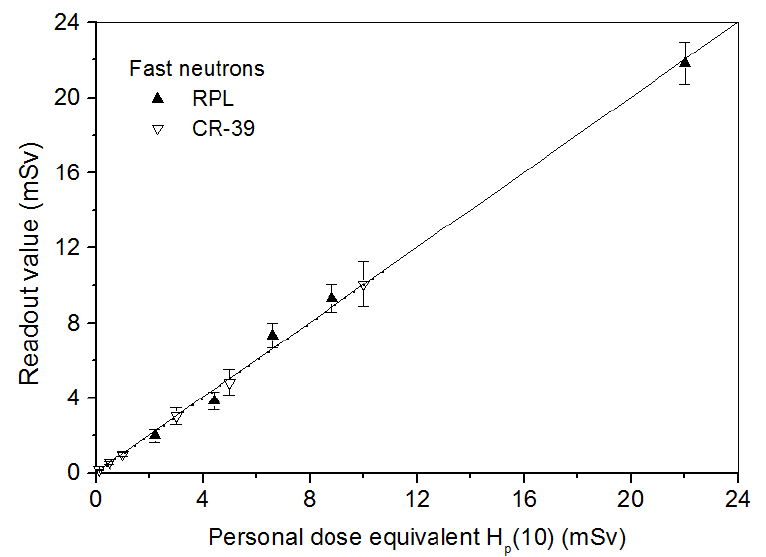
Figure 4. Linear responses of RPL and CR-39 detectors in terms of personal dose equivalent to fast neutrons at normal incidence.